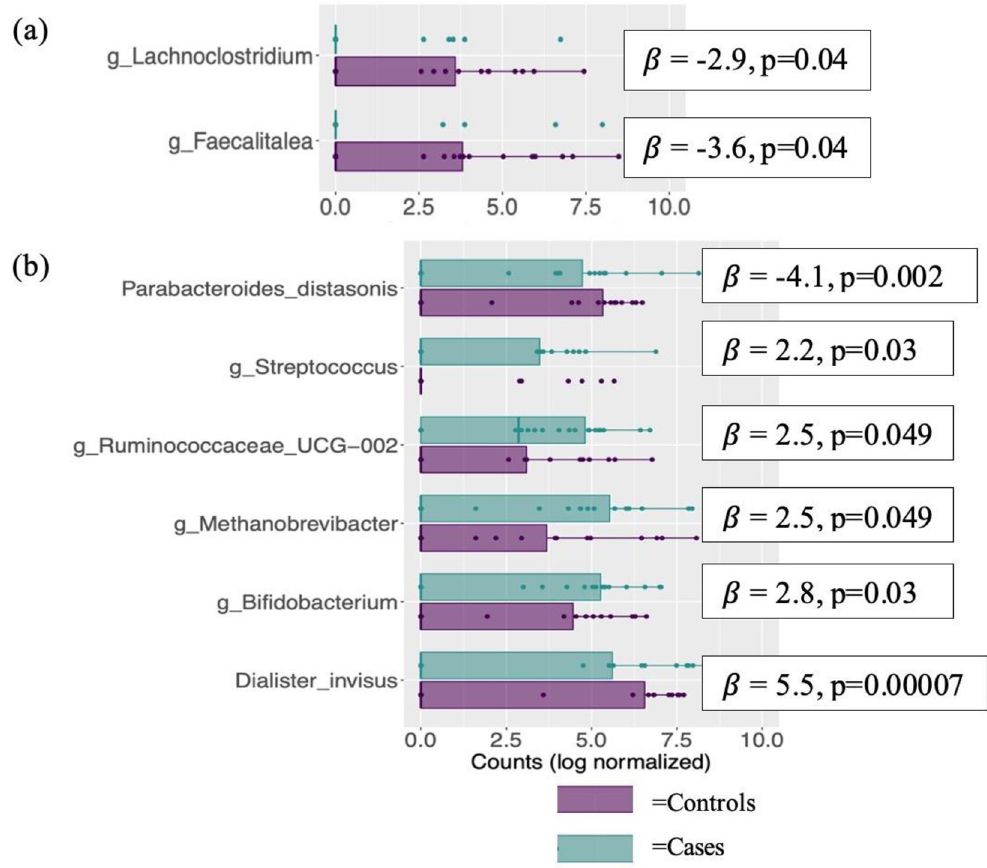
Fig 3. ASV’s differentially abundant between cases and controls. ASV’s differentially abundant between cases = blue squares and controls = purple squares in (a) unadjusted model and a (b) model adjusted by sedentary time, College Graduate (Y/N), usage of microbiome-altering and anti-inflammatory medication and DBP. Abbreviations: ASV— Amplicon Sequence Variant; DBP—Diastolic Blood Pressure; MCI—Mild Cognitive